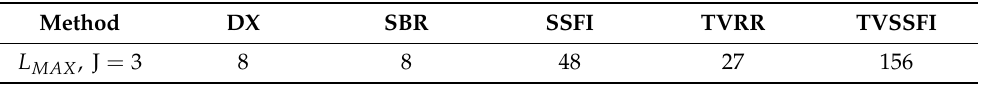
Table 8. Summary of the theoretical value of the maximum number of diagnoses L MAX for the analysed methods.